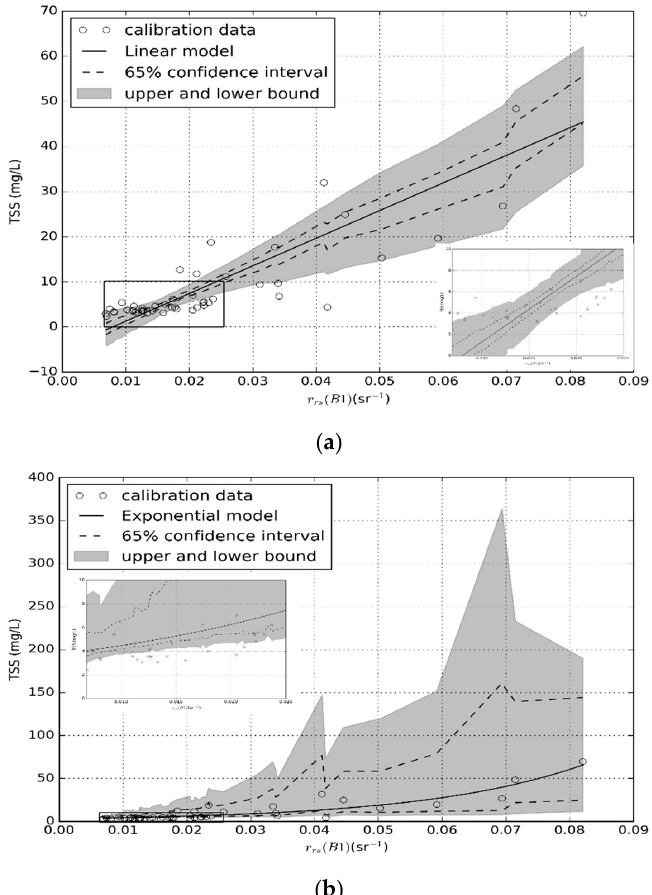
Figure 5 . The empirical model curve for r rs (B1) is shown by the solid line, in situ data points shown by open circles for both ( a ) the linear model and ( b ) the exponential model. In both the figures the 65% confidence limit obtained through the bootstrap method are shown by dashed lines. The greyed region represents the upper and lower bound for 1000 bootstrap runs. The upper and lower bound for exponential model has been limited to 95% CI because few high values of TSS were in excess of several thousand mg/L. The box at the bottom right in ( a ) and middle left ( b ) is a blow out of the TSS < 10 mg/L and r rs (B1) < 0.025 sr − 1 .